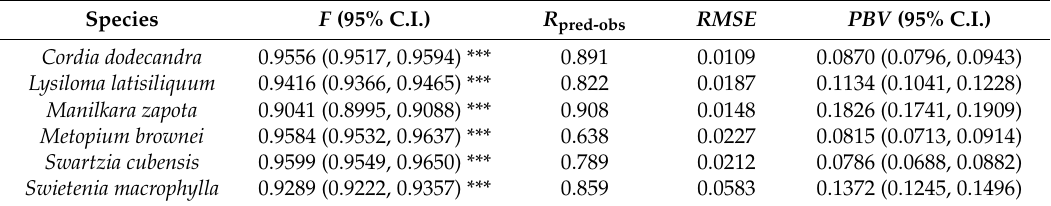
β 3 : coefficient in Equation (4); R pred ‐ obs : correlation between predicted and observed values; RMSE : residual mean square error; *** p < 0.005. Table 4. Nonlinear models predicting bark volume based on the total volume and bark factor (Equation (5)) and proportion of bark volume (Equation (6)).